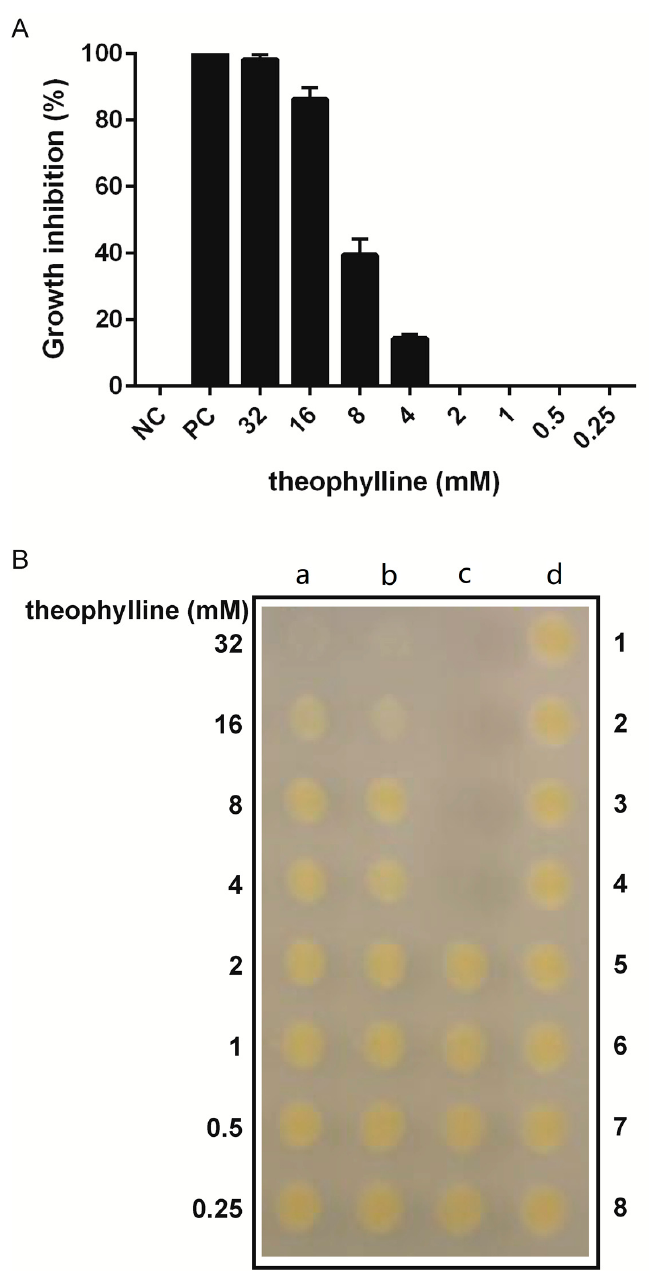
Figure 3. Xanthomonas citri growth inhibition induced by theophylline. Bacteria were exposed to theophylline at the concentration range varying from 0.25 to 32 mM using a Resazurin Microtiter Assay (REMA) setting. Growth inhibition was determined by monitoring the cell respiratory activity using resazurin ( A ), and the ability to resume growth after treatment (bacteriostatic/bactericidal effect) was investigated by cell plating ( B ). ( A ) Dose-response data derived from the growth inhibition experiment. Bars indicate the average percentage of growth inhibition, while lines above the bars represent the standard deviation of the means. NC: untreated cells; PC: positive control kanamycin at 20 mg/mL. ( B ) Samples were collected from REMA and inoculated on NYG-agar plates, without theophylline, to evaluate the ability of the cells to resume growth. ( a ) 1–8 and ( b ) 1–8 illustrate a replica experiment in which cells were exposed to theophylline at the concentrations indicated; ( c ) 1–4, positive control treated with kanamycin at 20 mg/mL; ( c ) 5–8, vehicle control, water used to dissolve theophylline, and ( d ) 1–8, negative control, untreated cells. All data were derived from three independent experiments.